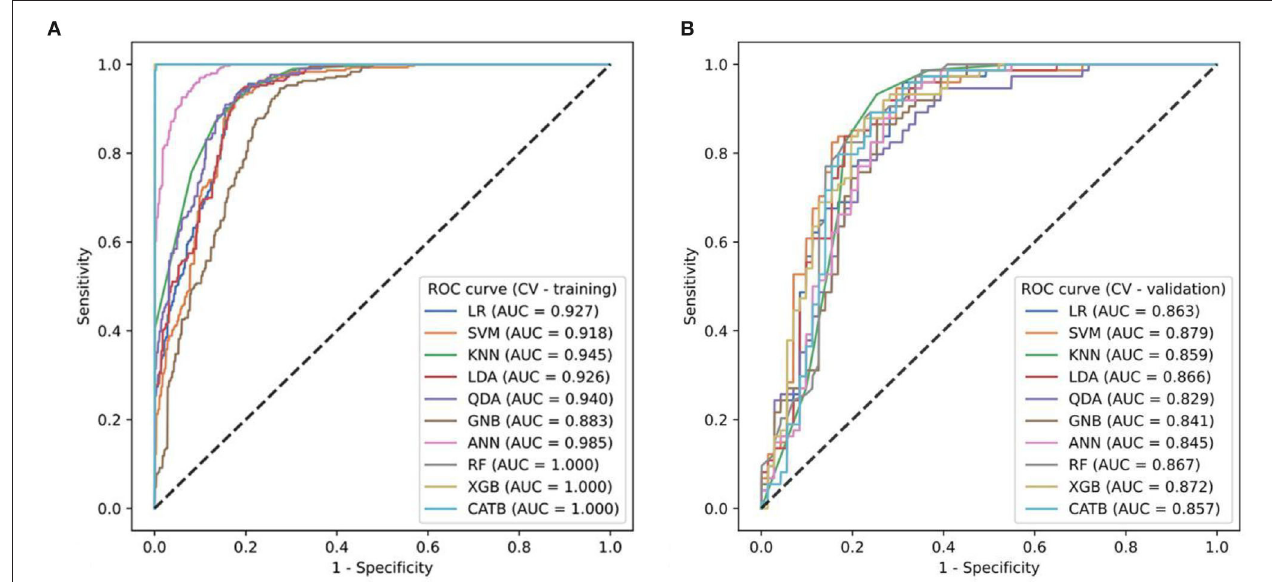
FIGURE 3 | (A,B) The ROC curves of ten ML models for predicting progressive hemorrhage of cerebral contusion.